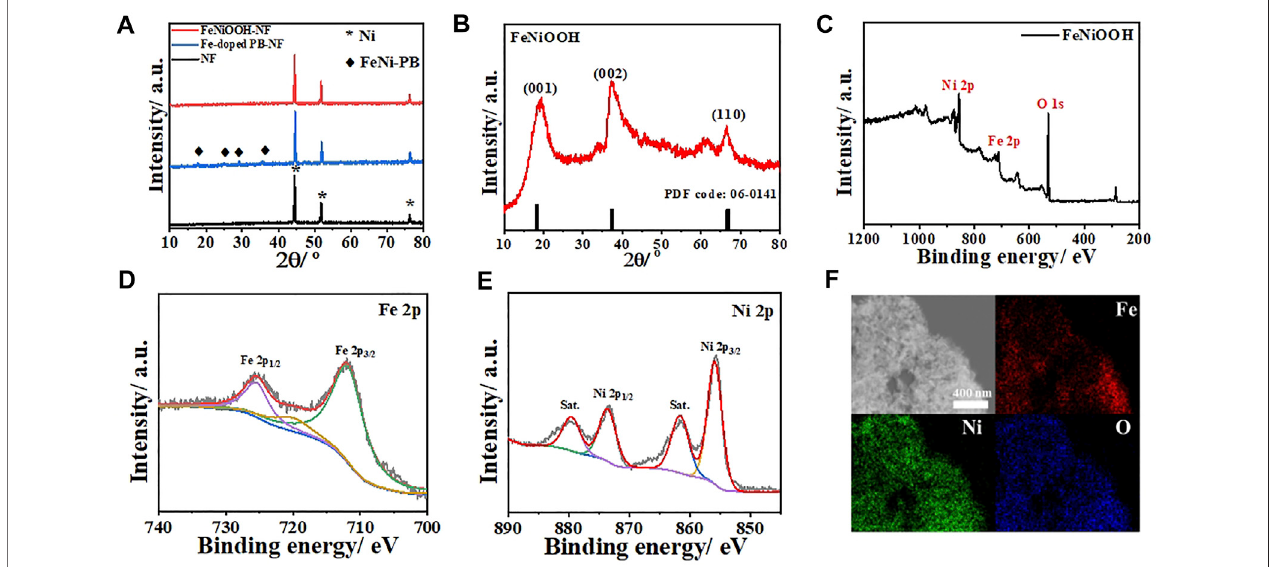
FIGURE 2 | (A) XRD patterns of NF, Fe-doped FeNi-PB on NF and FeNiOOH on NF. (B) XRD pattern of FeNiOOH scraped from FeNiOOH-NF. (C) XPS survey of FeNiOOH scraped from FeNiOOH-NF. (D) High-resolution Fe 2p spectra. (E) High-resolution Ni 2p spectra. (F) Element mapping images of FeNiOOH nanosheets with Fe, Ni and